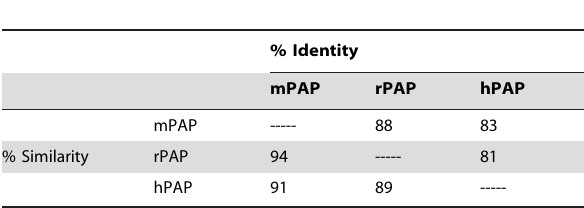
Table 1. Amino acid identity and similarity between the secretory isoforms of mouse, rat and human PAP.